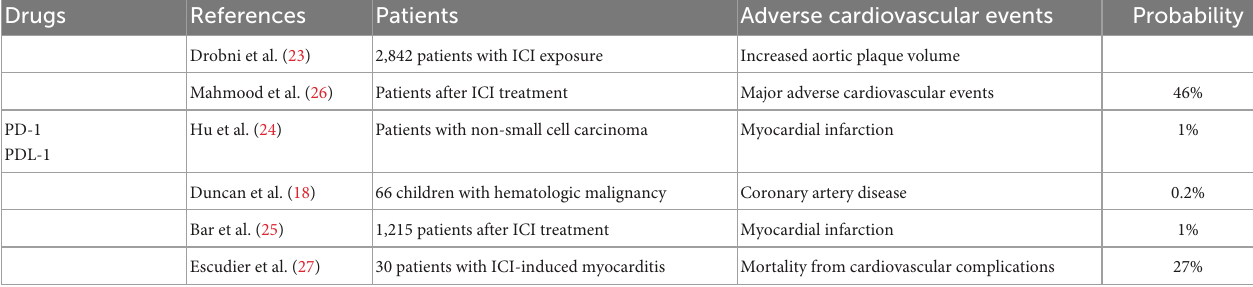
TABLE 2 Progress of clinical research on cardiovascular toxicity of immune checkpoint inhibitors. Drugs